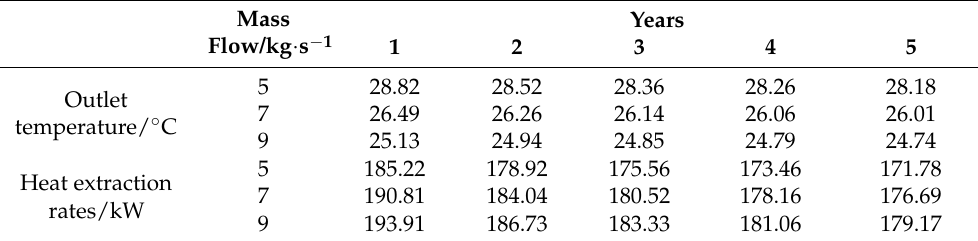
Table 4. Outlet temperature and heat extraction capacity over five years.